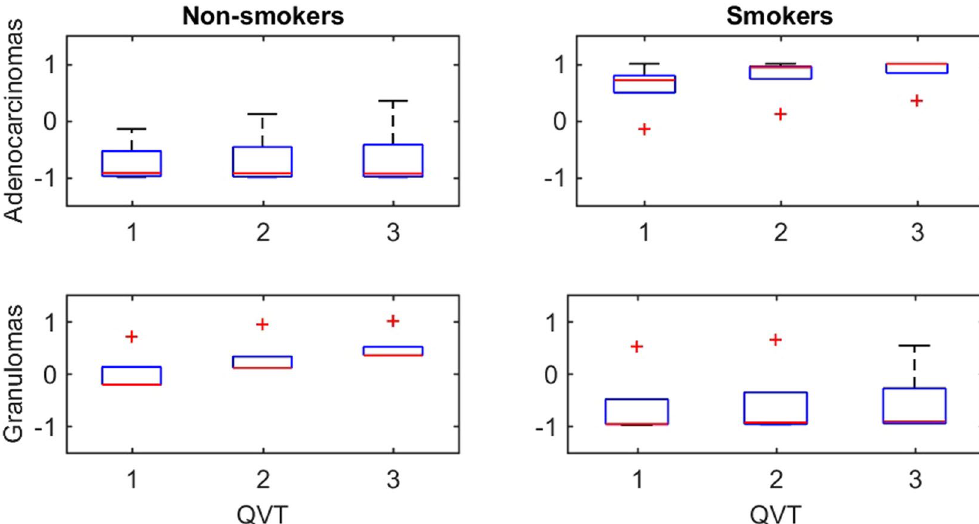
Figure 8. A set of 20 cases including 10 adenocarcinomas and 10 granulomas was selected. Within each group, five were non-smokers and five were smokers and had at least 50 pack years. Three QVT features were statistically different (p < 0.01) between smokers and non-smokers, both within the set of adenocarcinomas and